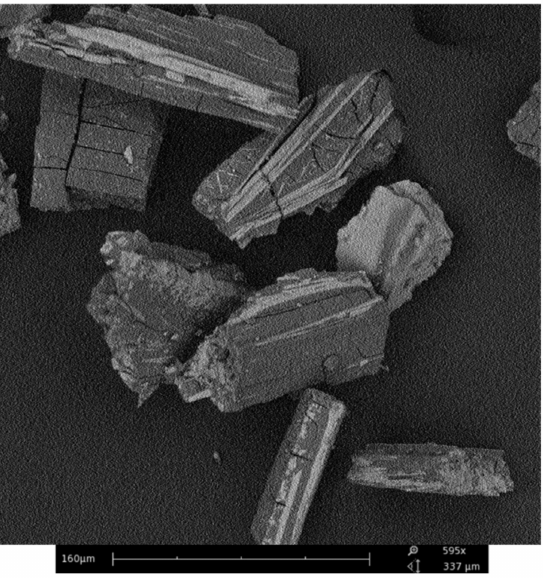
Figure 8. SEM image of HGAm